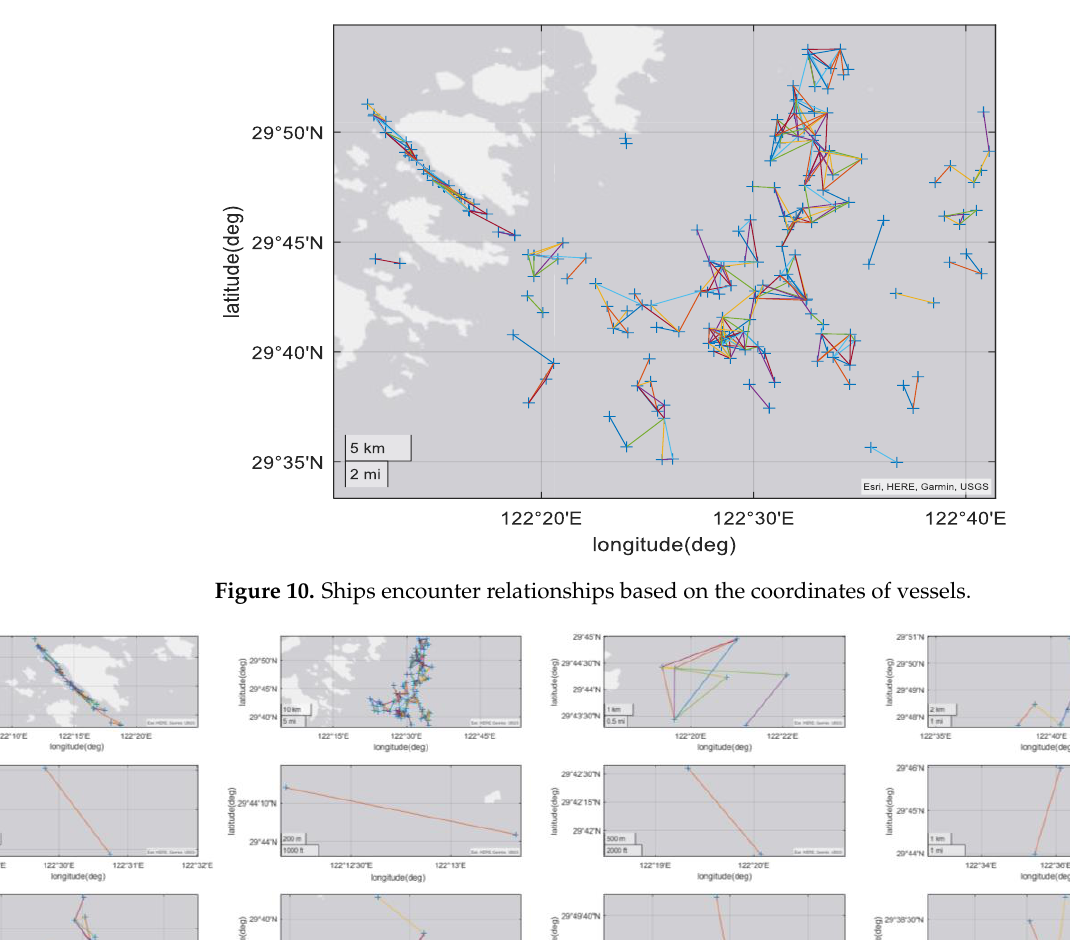
Figure 9. The identification flow of multiple ship encounters.